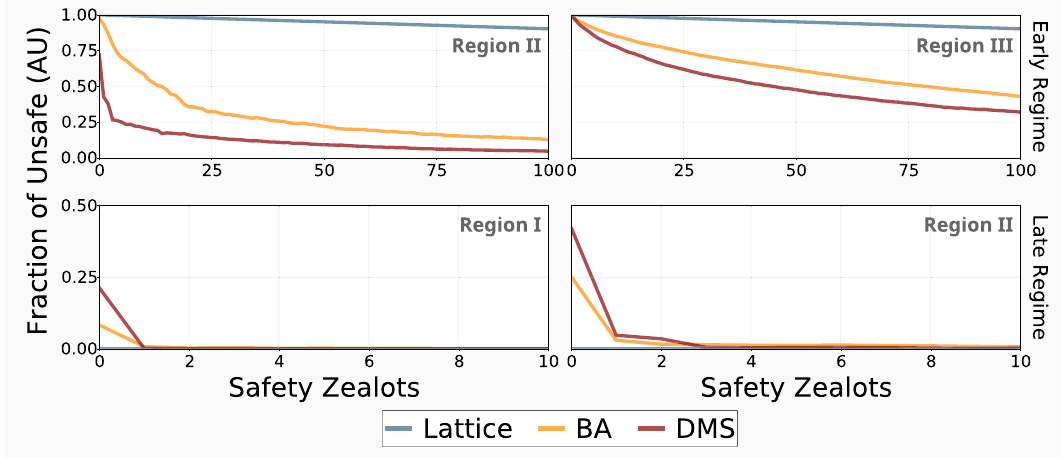
Figure 4. Introducing a small number of safety zealots can mitigate race tensions under uncertainty. We show the results for both regimes, as well as the appropriate regions where safety (early region II and late region I), and conversely where innovation (early region III and late region II) are the preferred collective outcomes. The top panels report the results for the early regime ( p fo = 0.5, W = 100 with p r = 0.5 for region II and p r = 0.1 for region III), and the bottom do so for the late regime ( p fo = 0.6, W = 10 6 with p r = 0.3 for region I and